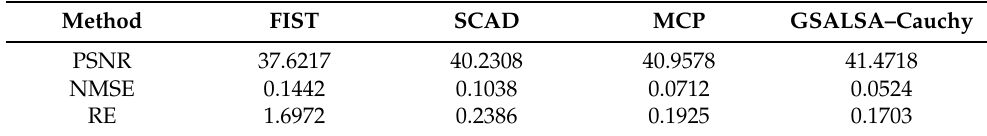
Figure 9. The imaging results of the pistol corresponding to the 75% sampling rate. ( a ) The MF result. ( b ) The FIST result. ( c ) The SCAD result. ( d ) The MCP result. ( e ) The GSALSA–Cauchy result. Table 5. PSNR, NMSE and RE of pistol model with full sampling.